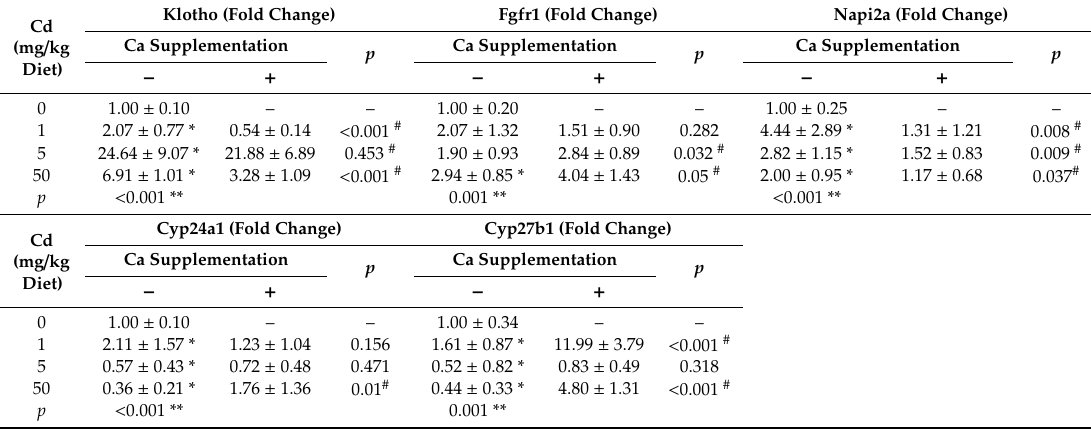
Table 13. Expression changes of FGF23 / Klotho-associated gene using quantitative real-time polymerase chain reaction in the kidney in the study of moderate Ca supplementation exposure to di ff erent diet Cd (Exp